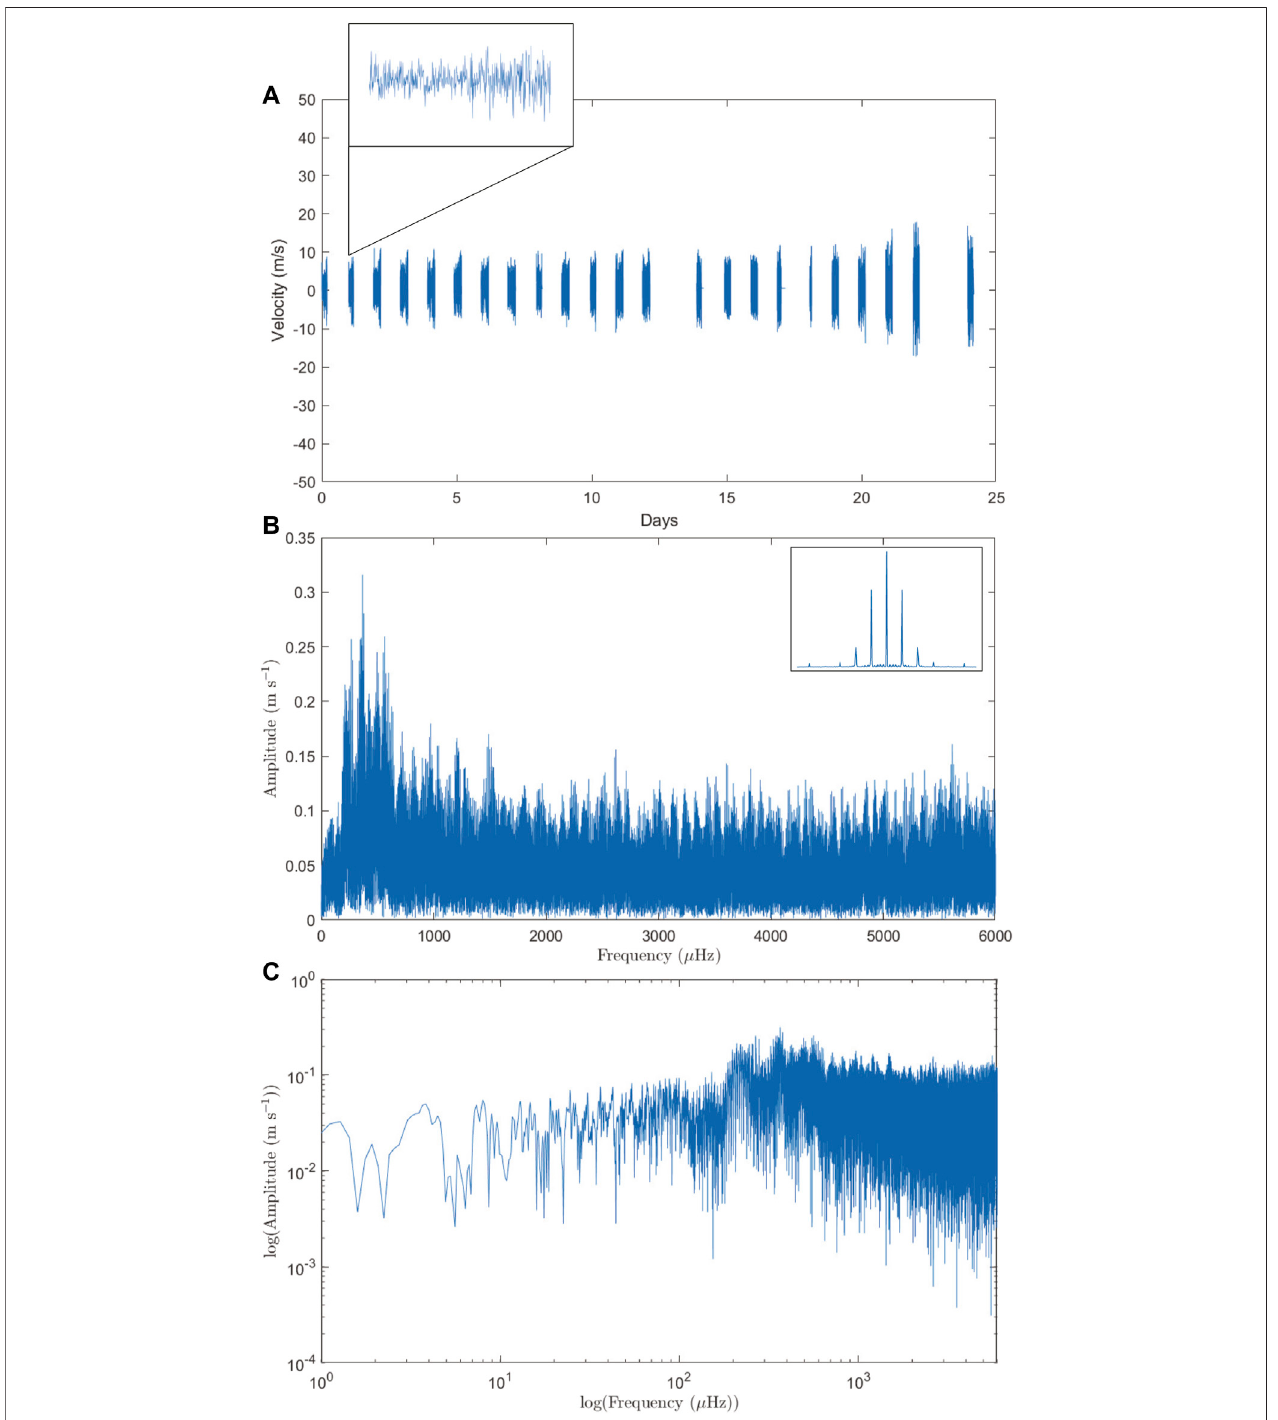
FIGURE 10 | (A) : Y m l (cid:1) ( 1 , 0 ) time series for the full 24-day observational campaign. A representative night is shown in an inset for ease of interpretation. (B) : Preliminary Y m l (cid:1) ( 1 , 0 ) calibrated amplitude spectrum for the full 24-day observational campaign. The window function is shown as an inset in the upper right-hand corner of this panel. (C) : Preliminary Y m l (cid:1) ( 1 , 0 ) amplitude spectrum, as in (B) , in a log-log scale.